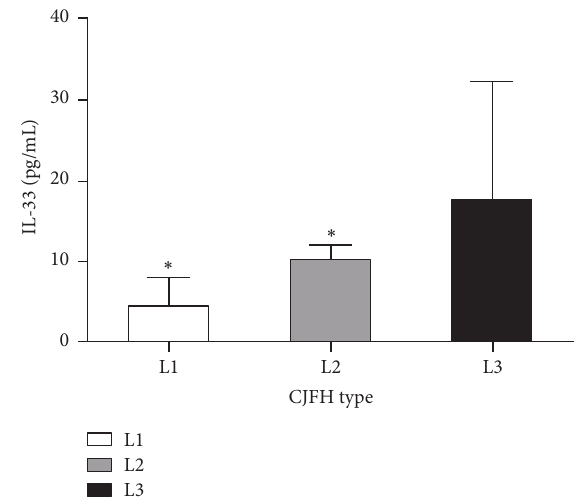
Figure 3: The IL-33 levels of CJFH type L3 patients were signif- icantly higher than that of CJFH types L1 ( 𝑃 = 0.003 ) and L2 ( 𝑃 = 0.028 ) patients. ∗ 𝑃 < 0.05 compared with patients with type L3.